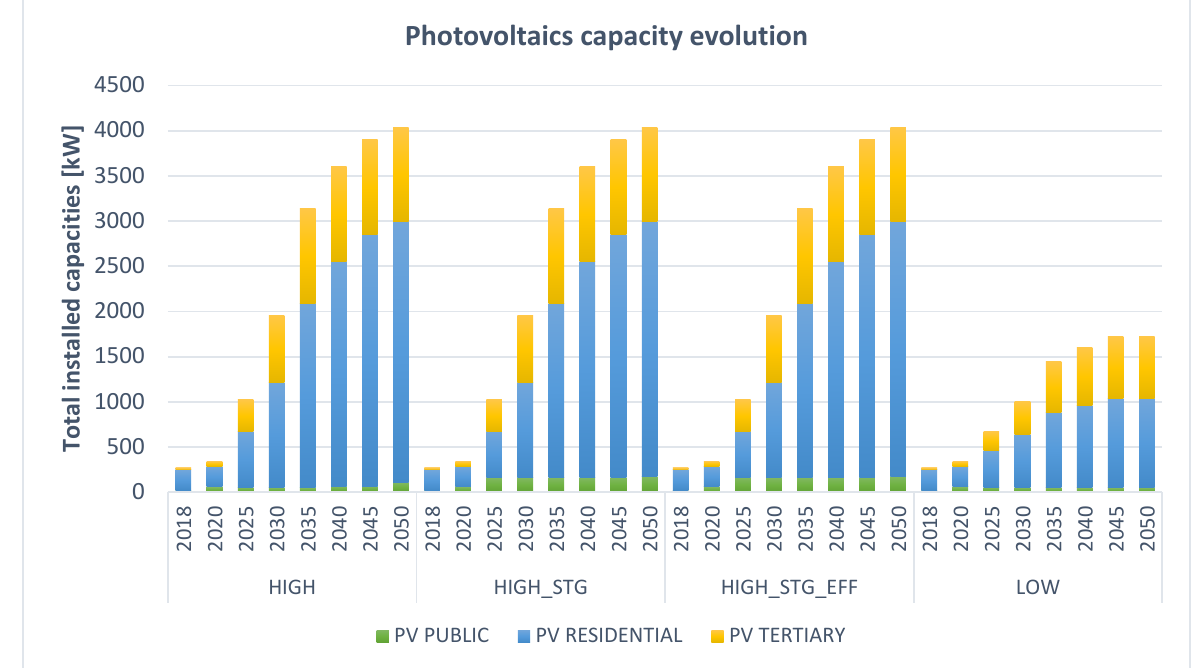
Figure 15. Optimal photovoltaics capacities evolution in the four investigated scenarios.